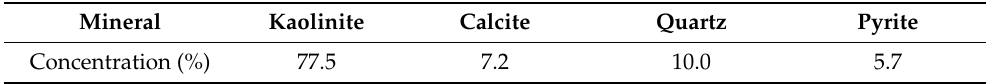
Table 3. Mineral concentrations of the KAS.